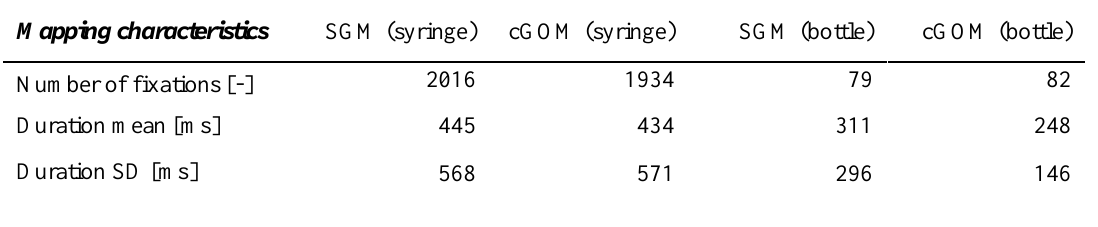
Table 1: Overview statistics of the fixations mapped by SGM and cGOM for the objects syringe and bottle. The applied statistics are number of fixation [-], fixation duration mean [ms] and fixation duration standard deviation [ms].